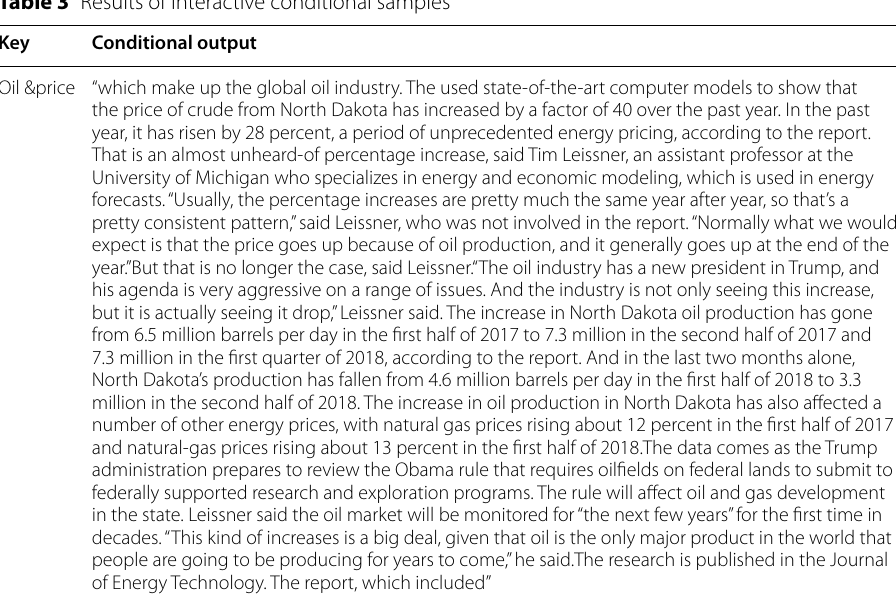
Table 3 Results of interactive conditional